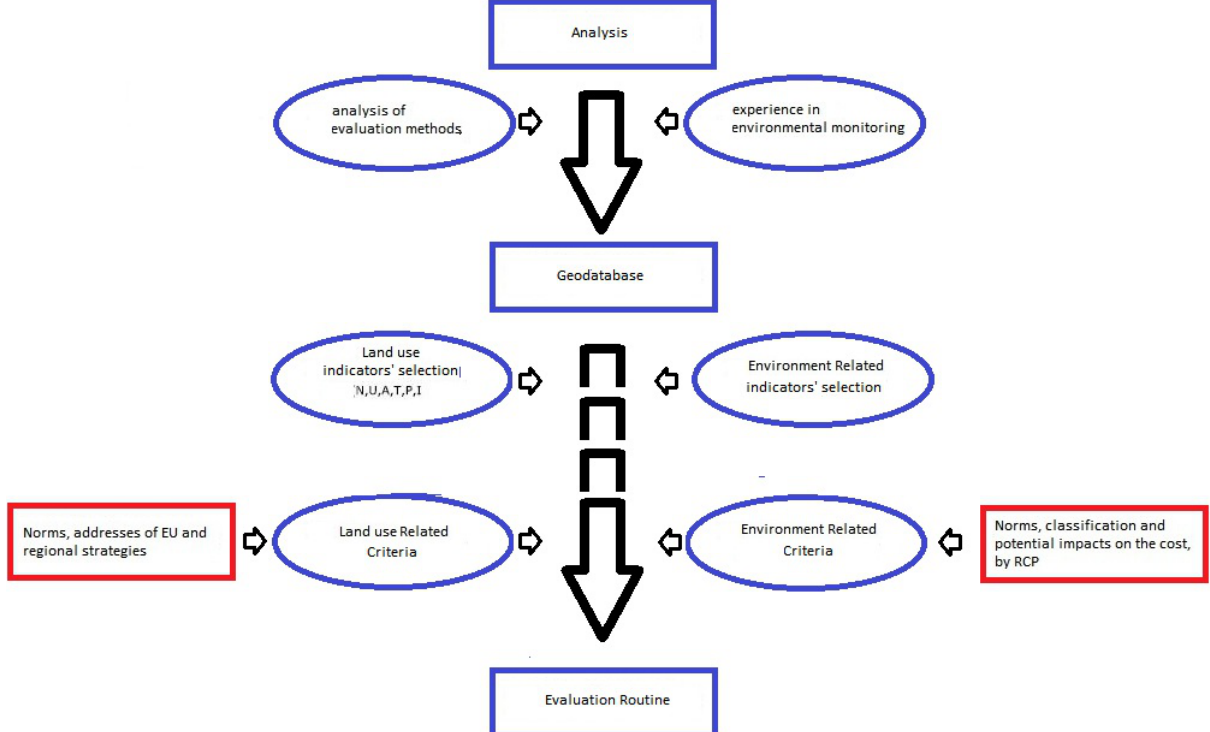
Fig. 2. Logical path of the